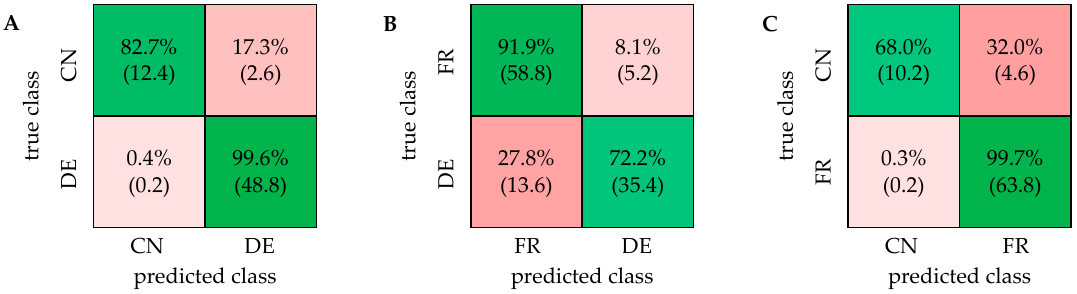
Figure 3. Confusion matrices of the discrimination of walnut samples from three different countries based on the 1D 1 H NOESY spectra. CN: China; DE: Germany; FR: France. ( A ): Accuracy: 95.9% (±0.8%), ( B ): Accuracy: 83.4% (±2.0%), ( C ): Accuracy: 93.7% (±1.1%).